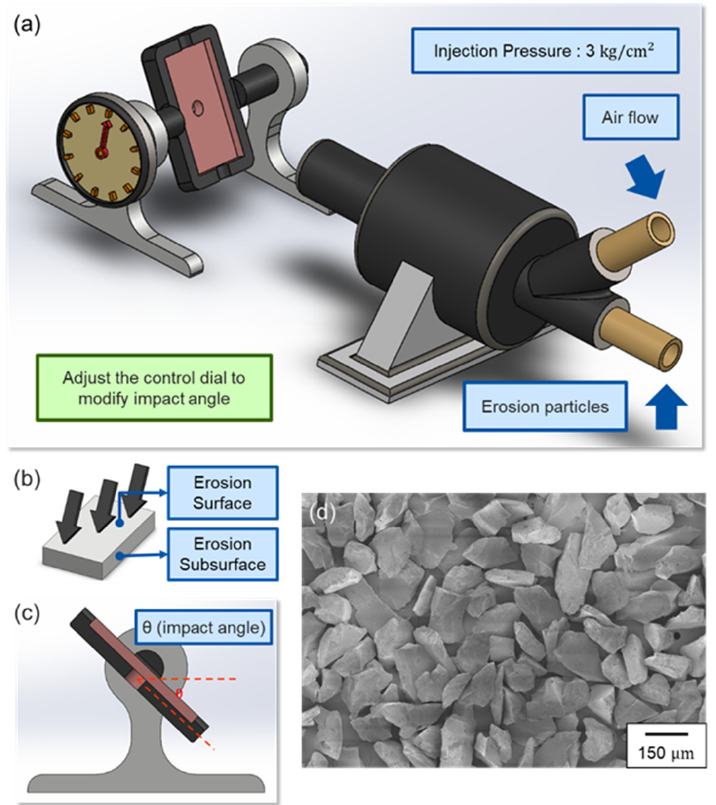
Figure 3. ( a ) The erosion test equipment developed by our group, ( b ) the position of the erosion surface (working surface) and the erosion subsurface, ( c ) the cross-sectional view of the specimen carrier and the definition of impact angle, and ( d ) Al 2 O 3 ceramic particles for erosion wear